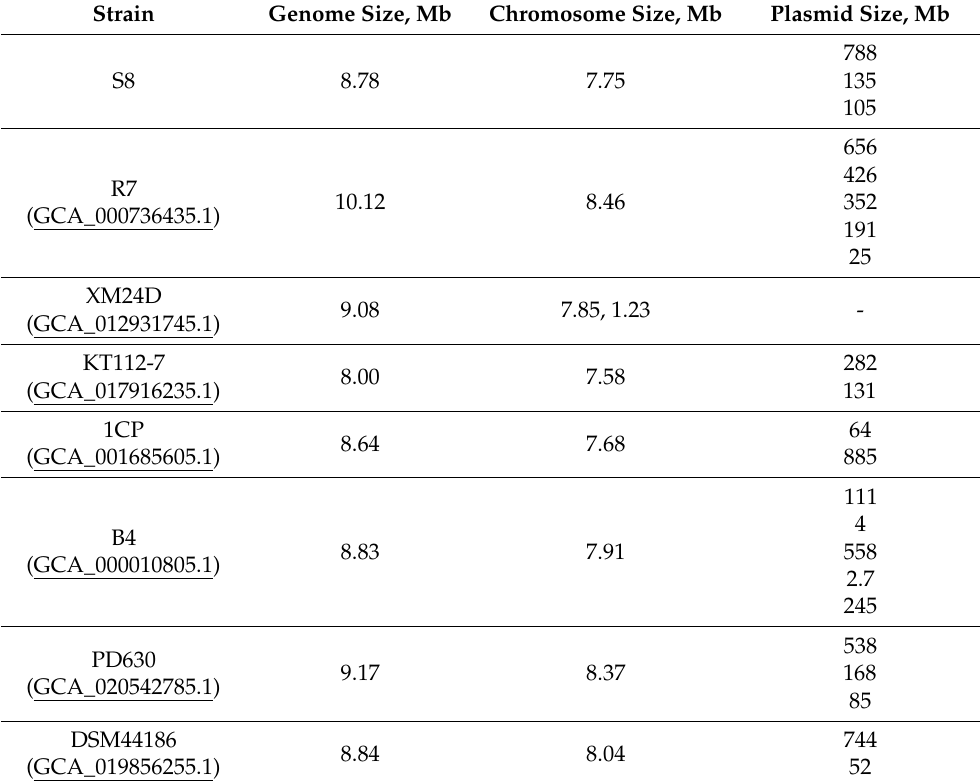
Table 3. Comparison of R. opacus genomes deposited in the Genbank database. For comparison, only complete genomes were taken.